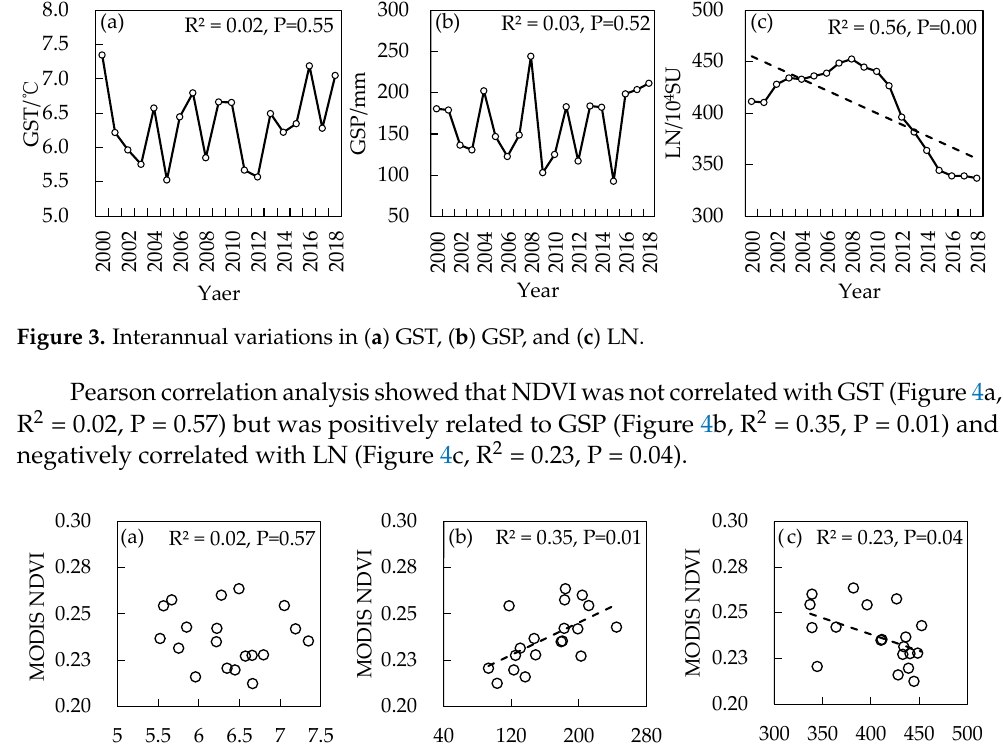
3.2. Variations in Climatic Factors and the Number of Livestock and Their Relationships with NDVI In this area, GST (Figure 3a, R 2 = 0.02, P = 0.55) and GSP (Figure 3b, R 2 = 0.03, P = 0.52) did not vary during 2000–2018. However, LN reflected a significant decreasing trend (Figure 3c, R 2 = 0.56, P = 0.00), especially after 2008.